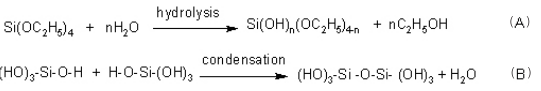
Scheme 1. Hydrolysis and condensation reactions of